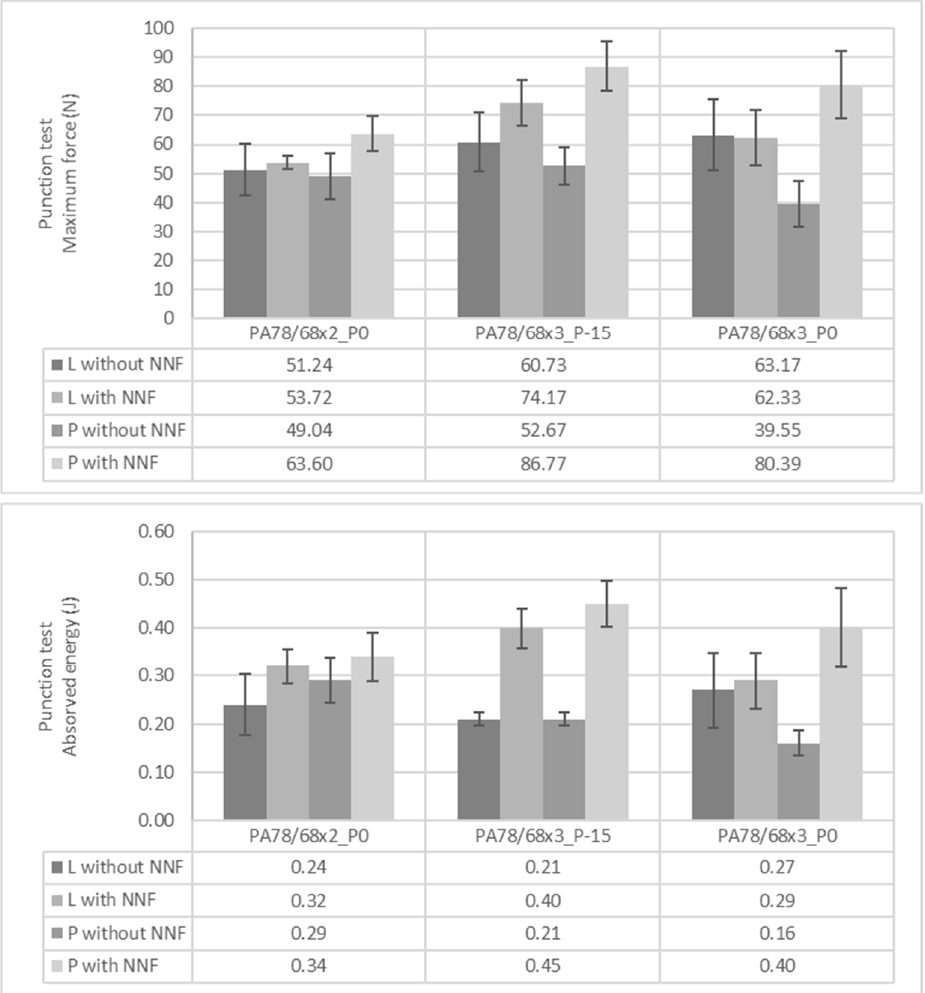
Figure 8. Maximum force and absorbed energy of knits with L and P pattern obtained on punction tests.